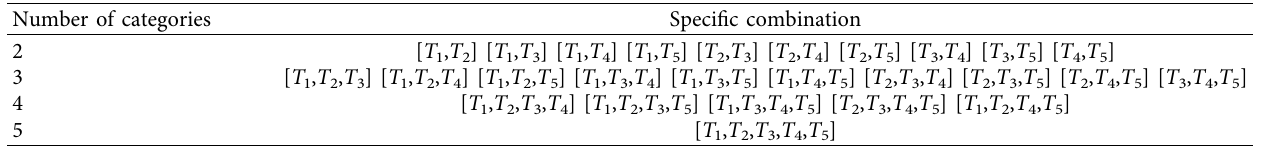
Table 3: Task combinations with different classification numbers.